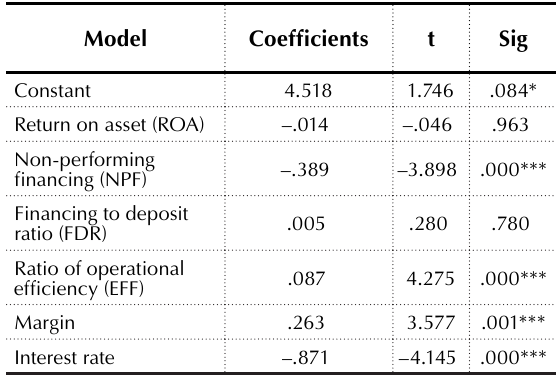
Table 3. Estimation